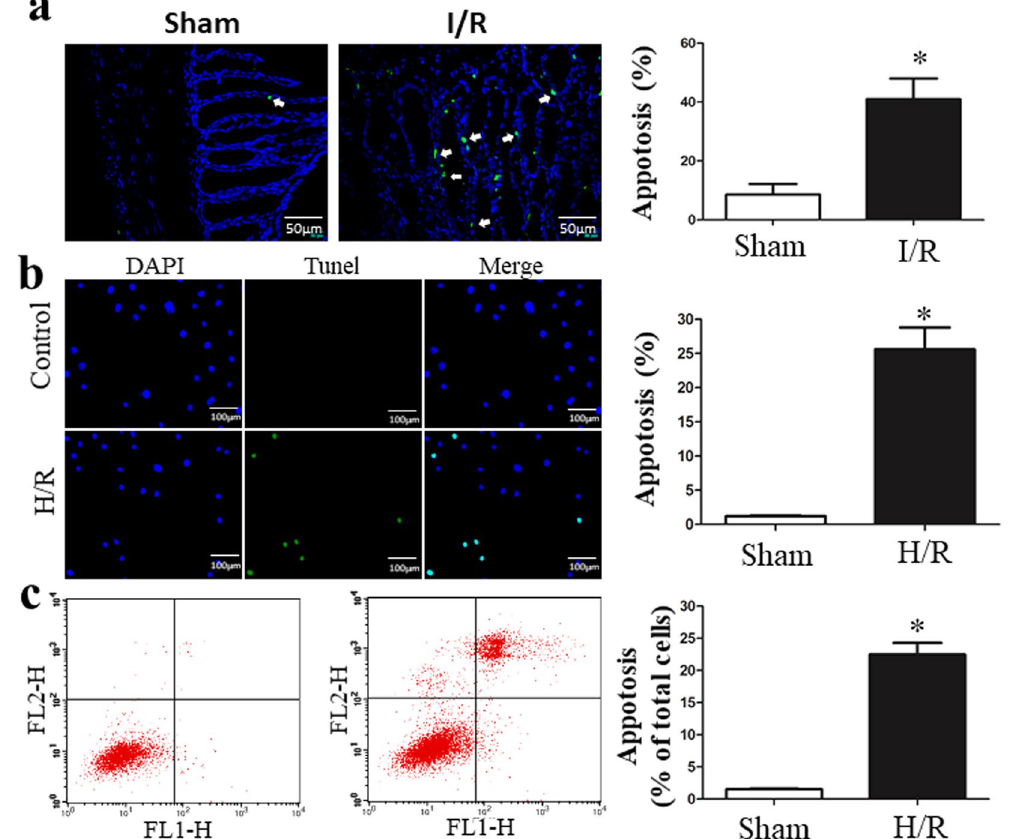
Figure 6. I/R induces cell death. ( a ) Intestinal I/R caused fragmentary or pyknotic-like nuclei, and the chromatin was aggregated in the areas surrounding the nuclei. ( b ) Representative images and the apoptosis index of in situ TUNEL assay of IEC-6 cells. TUNEL-positive is green and DAPI is blue. ( c ) AnnexinV/ PI analysis with flow cytometry confirmed that H/R-induced cell death. Data are expressed as mean ± SD. * P < 0.05 vs H/R